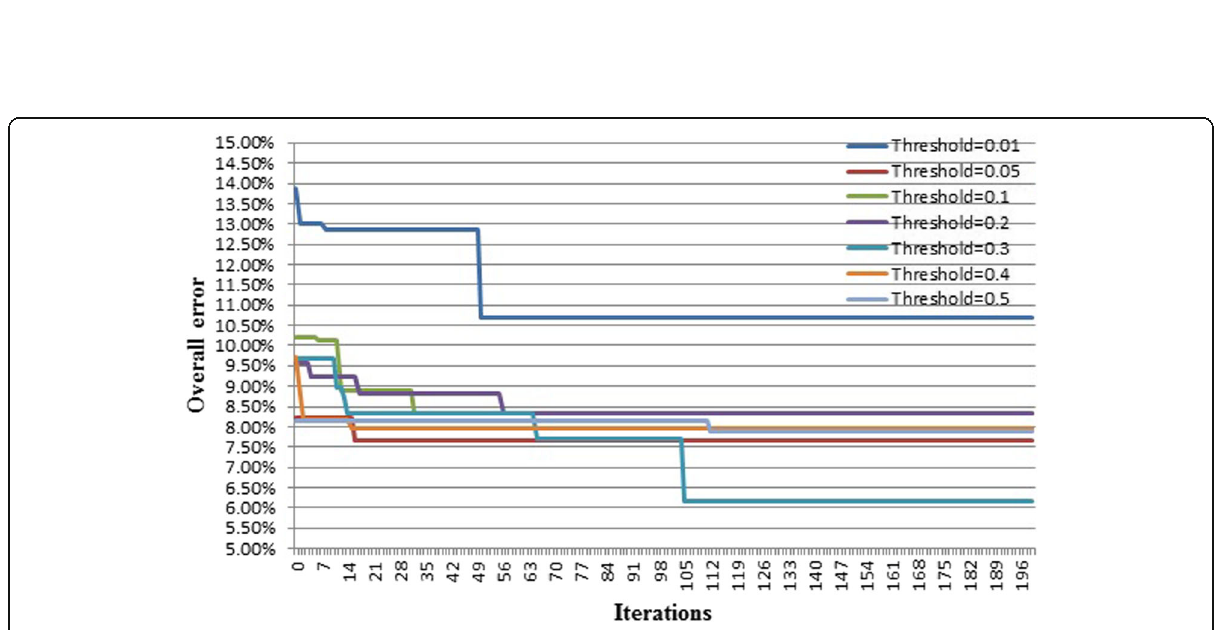
Fig. 9 The overall error variation of the GA-AdaboostRBFSVM classifier at different training error thresholds